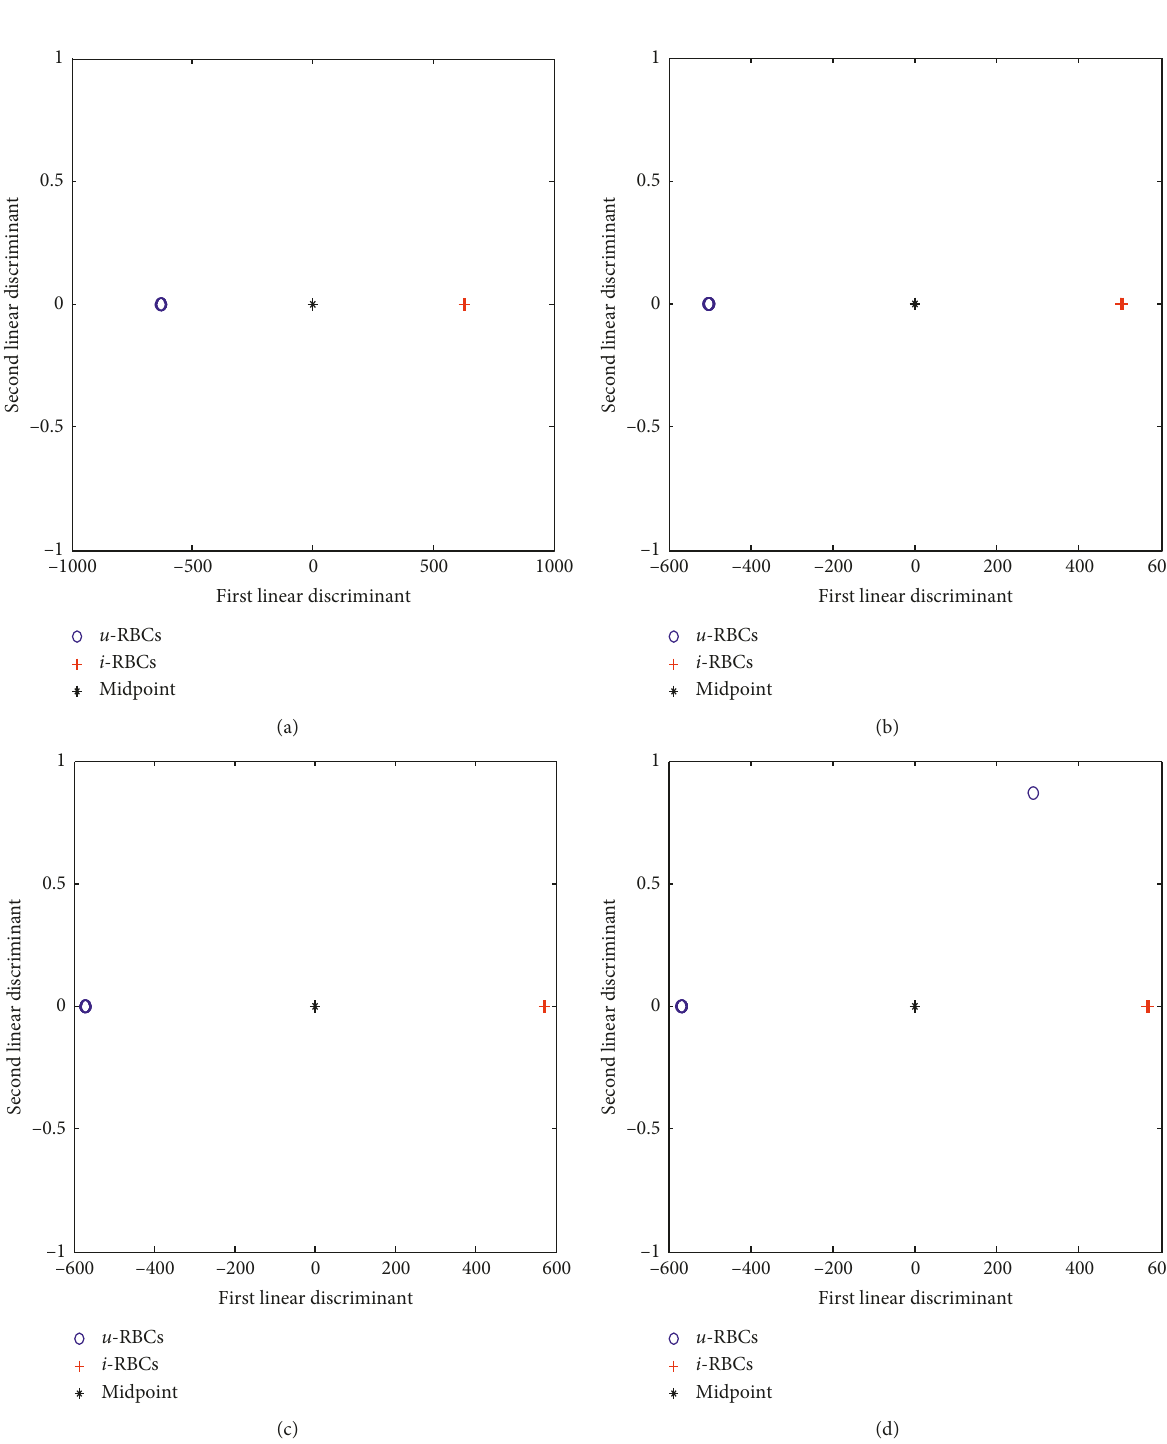
Figure 6: Scatter plots of first and second Fisher’s linear discriminants showing transmitted pixel intensities of uninfected red blood cells ( u -RBCs) and Plasmodium falciparum -infected human red blood cells i -RBCs (+) with parasite density: (a) (+), (b) (++), (c) (+++), and (d) (++++) for 435nm illumination light